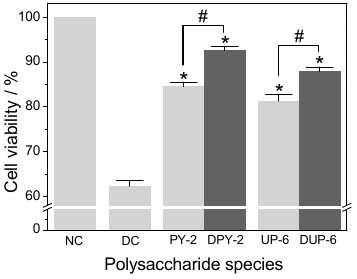
Figure 6. Cell repair activity of selected polysaccharides of different molecular weight on damaged HK-2 cells. Data were expressed as Mean ± SD from three independent experiments. Compared with damaged control group, * indicates p < 0.01. # indicates p < 0.05. NC: Normal control; DC: Damaged control; LJ-1: Laminaria -1; DPY-2: degraded Porphyra -2; DGL-3: degraded Gracilaria -3; DSF-4: degraded Sargassum -4; EU-5: Eucheuma -5; DUP-6: degraded Undaria -6.